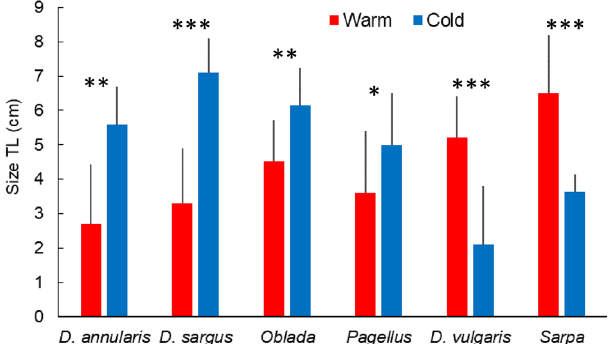
Figure 7. Mean size (TL cm ± SD) of some fish species juveniles settling in Mediterranean shallow coastal habitats. D. = Diplodus ; Oblada = Oblada melanura ; Pagellus = Pagellus spp.; Sarpa = Sarpa salpa . Warm: warm period (summer 2014); Cold: cold period (spring 2015). Results of t-test for difference in mean size of a given species according to period: *P < 0.05; **P < 0.01; ***P <